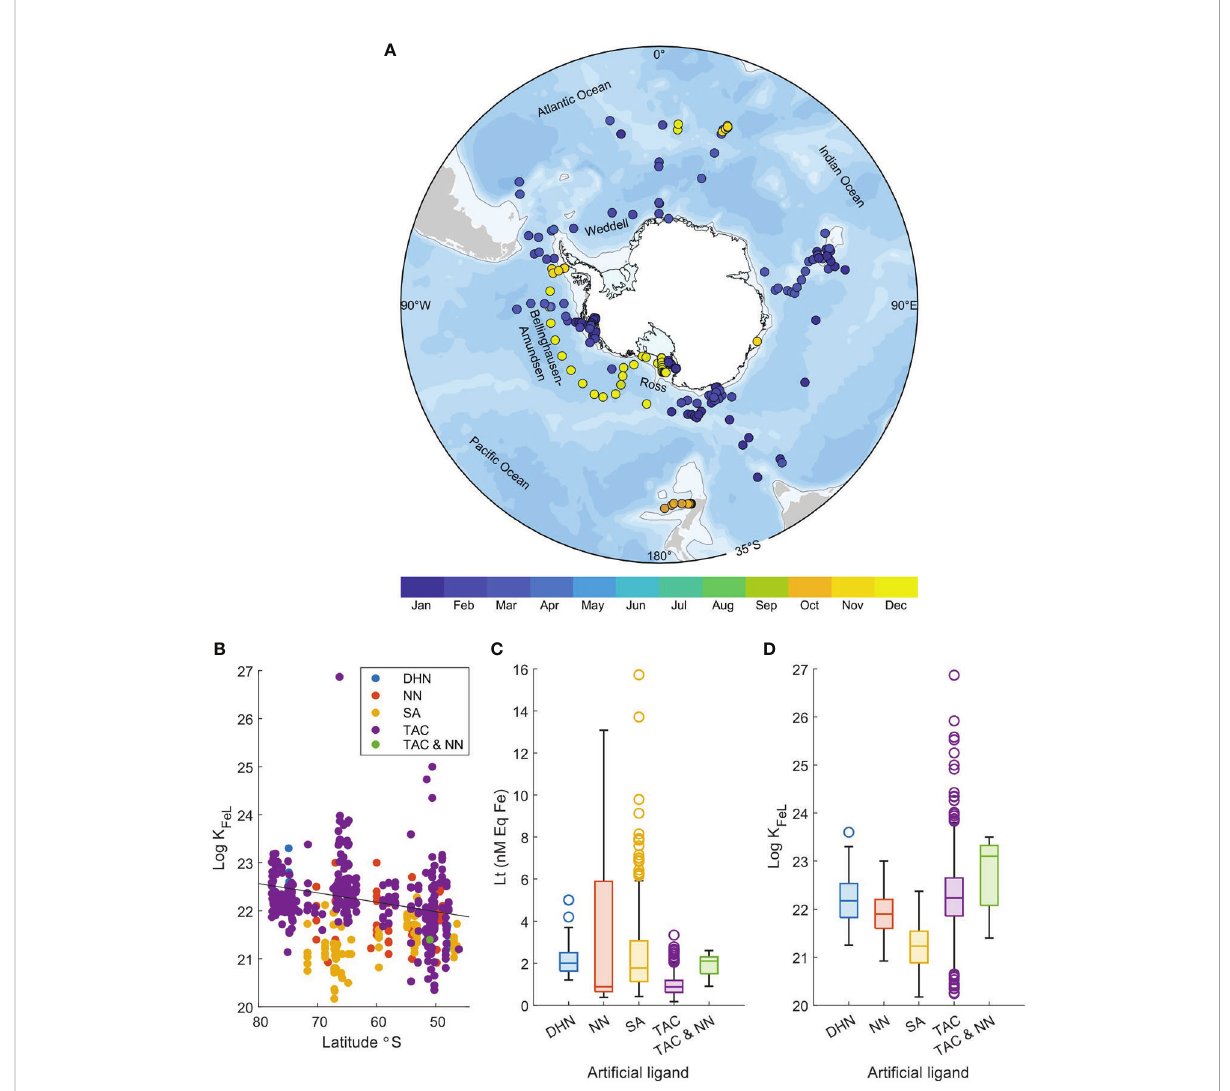
FIGURE 6 (A) Seasonal distribution of stations included in the Southern Ocean Ligand Collection. Colour bar represents sampling month. (B) Relationship between Log K FeL and latitude (°S) for deep samples collected >100 m, coloured by arti fi cial ligand used, including 2-(2-thiazolylazo)- p -cresol (TAC), 1-nitroso-2-napthol (NN), salicylaldoxime (SA) and 2,3-dihydroxynaphtalene (DHN). Box-and-Whisker plot of (C) Lt concentration (nM Eq Fe) and (D) Log K FeL with different arti fi cial ligand